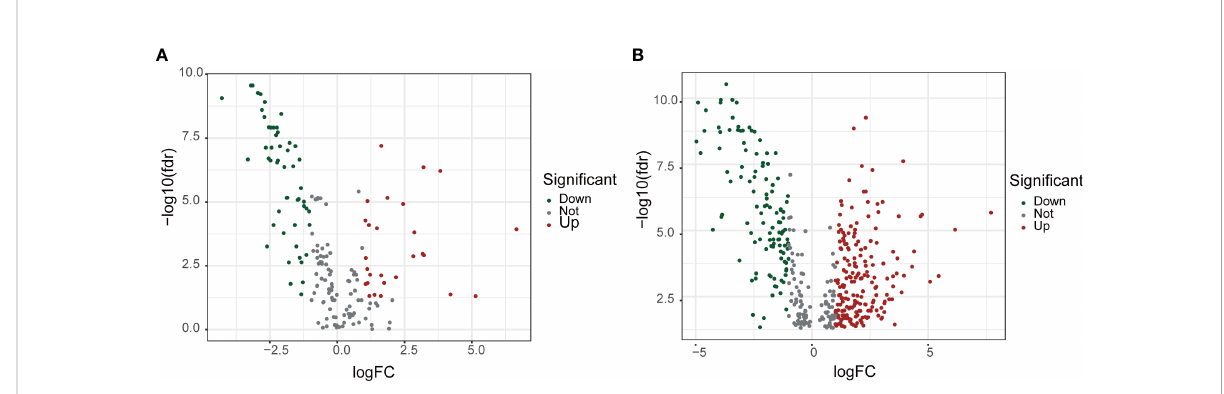
FIGURE 1 Screening for basement membrane-associated differential genes and differential LncRNAs. (A) Volcano plot of 79 basement membrane- associated differential genes. (B) Volcano plot of 304 basement membrane-associated differential